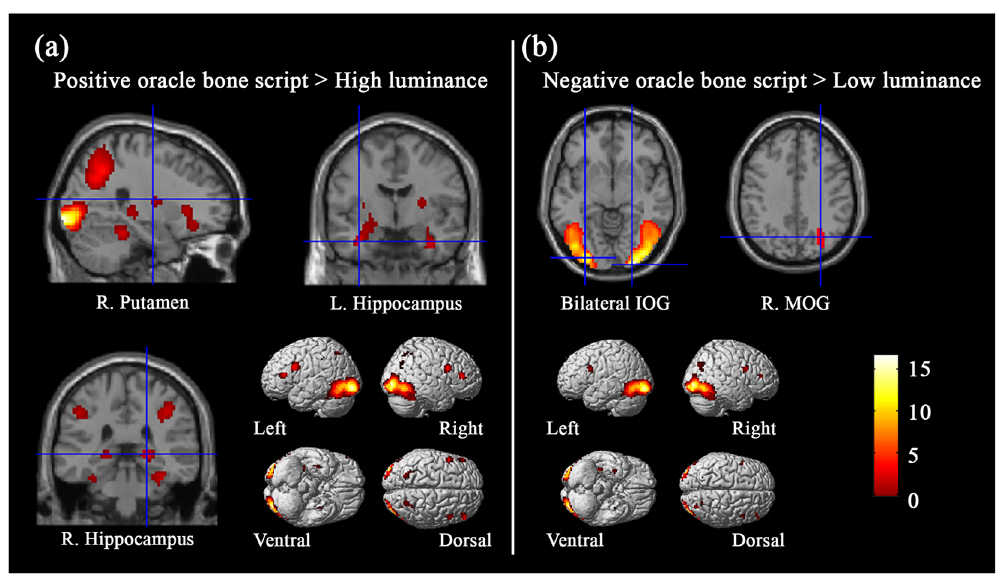
Figure 2. The main cerebral areas for aesthetic judgments of oracle bone